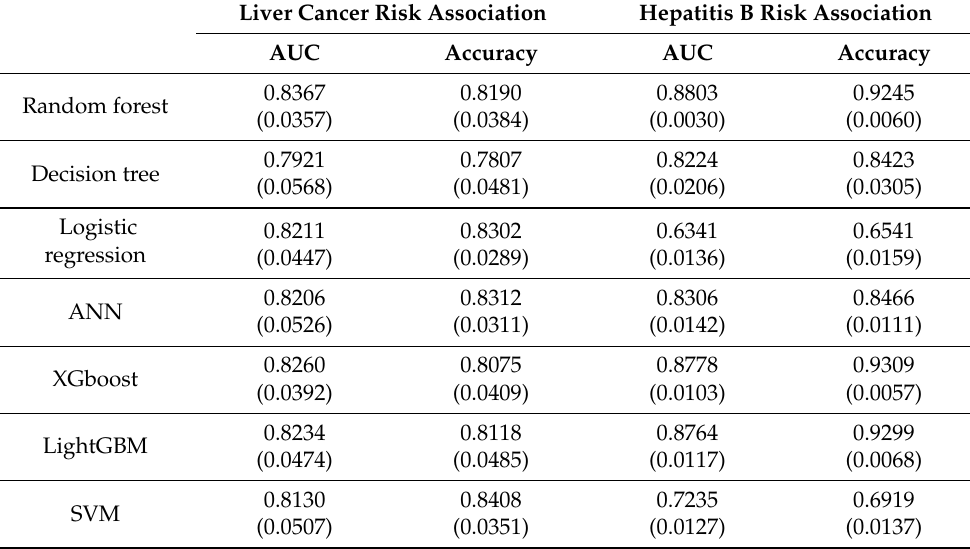
Table 6. Performances of risk association models and comparative models. Standard deviation is calculated in the